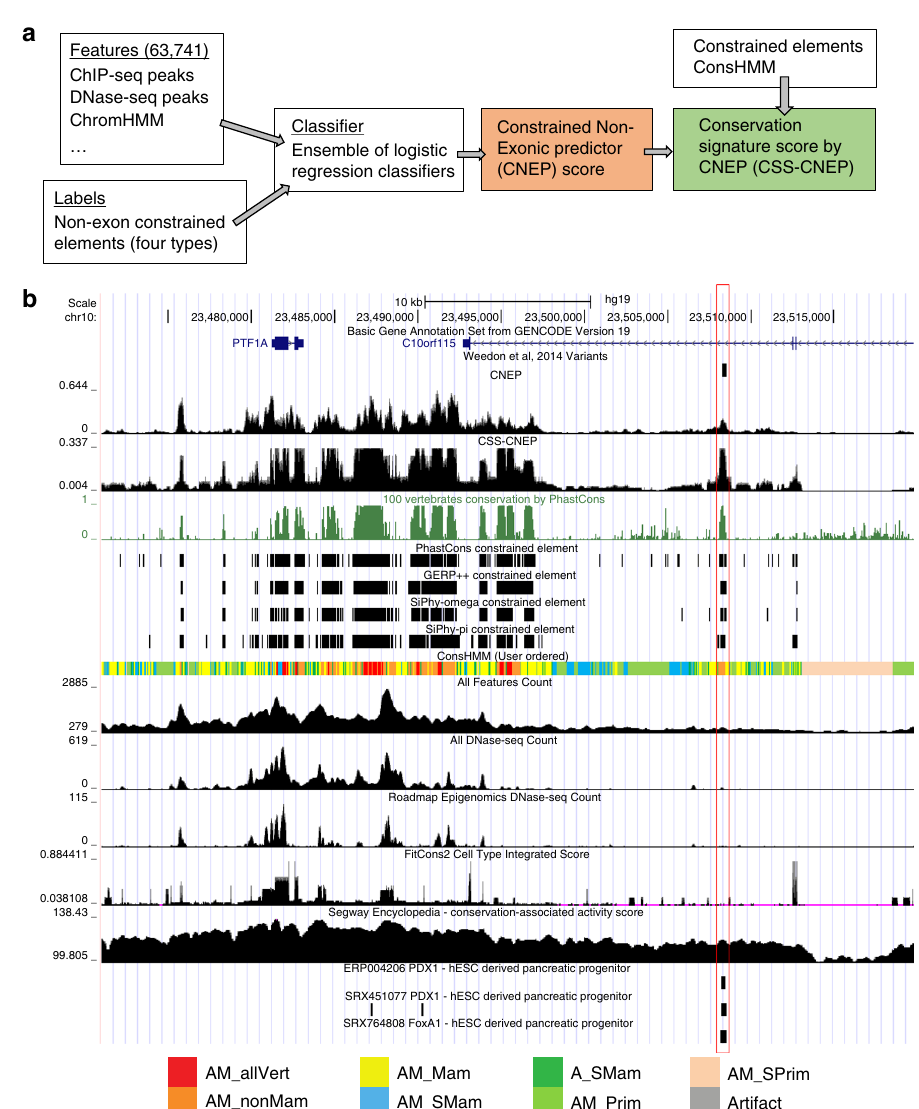
Fig. 1 Overview and example predictions of CNEP and CSS-CNEP. a A fl ow chart giving an overview of the approach to learn the CNEP score and the CSS- CNEP, which are shown in shaded boxes. The input to learn the CNEP score were a set of 63,741 epigenomic and TF-binding features such as ChIP-seq and DNase-seq peaks and ChromHMM annotations. These features were integrated using an ensemble of logistic regression classi fi ers that were trained based on annotations of constrained non-exonic elements from four methods. The CSS-CNEP was derived based on the CNEP score along with the four constrained element sets and ConsHMM annotations 32 . b An example genomic locus containing the PTF1A gene illustrating the CNEP score and the CSS- CNEP. The top line is the GENCODE gene annotation track. The next line shows the location of fi ve variants in close proximity that were previously identi fi ed to be associated with isolated pancreatic agenesis and fell into constrained non-exonic elements, but had limited prior informative epigenomic and TF-binding annotations 21 . A vertical box goes through these variants. The following tracks show the CNEP score, CSS-CNEP, and the PhastCons score. This is followed by tracks for the PhastCons, GERP ++ , SiPhy-omega, and SiPhy-pi 2,3,5 constrained element sets and the ConsHMM annotations 32 in dense view. Along the bottom is a color legend for the groups of ConsHMM conservation states as de fi ned in ref. 32 . For segments in red, species through fi sh have high aligning and matching to the human reference genome, while those in orange have that through some non-mammalian vertebrates. The next sets of tracks show baseline scores of counts of total features, DNase-seq features, and DNase-seq features from Roadmap Epigenomics overlapping a base followed by the FitCons2 cell type integrated score 22 and the Segway Encyclopedia conservation-associated activity score 24 . The fi nal set of tracks show peak calls for PDX1 and FoxA1 in hESC-derived pancreatic progenitors 21,49 that overlapped the SNP. These datasets were ranked using the CNEP software to be the top three datasets in terms of their overlap with constrained non-exonic elements as de fi ned by the expected CNEP score data as features for predictions. By using an ensemble of logistic CNEP ’ s predictions from training using any two different regression classi fi ers, CNEP provides a robust probabilistic individual constrained element sets were all highly correlated output. For each chromosome, CNEP trains a separate set of ([0.88,0.93]), and greater than the correlations directly between classi fi ers based on subsamples of positions from all chromo- different constrained element sets (Supplementary Fig. 4). As the somes except the target chromosome. CNEP then makes a CNEP score is based on the average of predictions based on probabilistic prediction for each base on the target chromosome training separately with four different constrained element sets, as to whether it is in a CNE element. this is expected to reduce biases associated with the choice of one